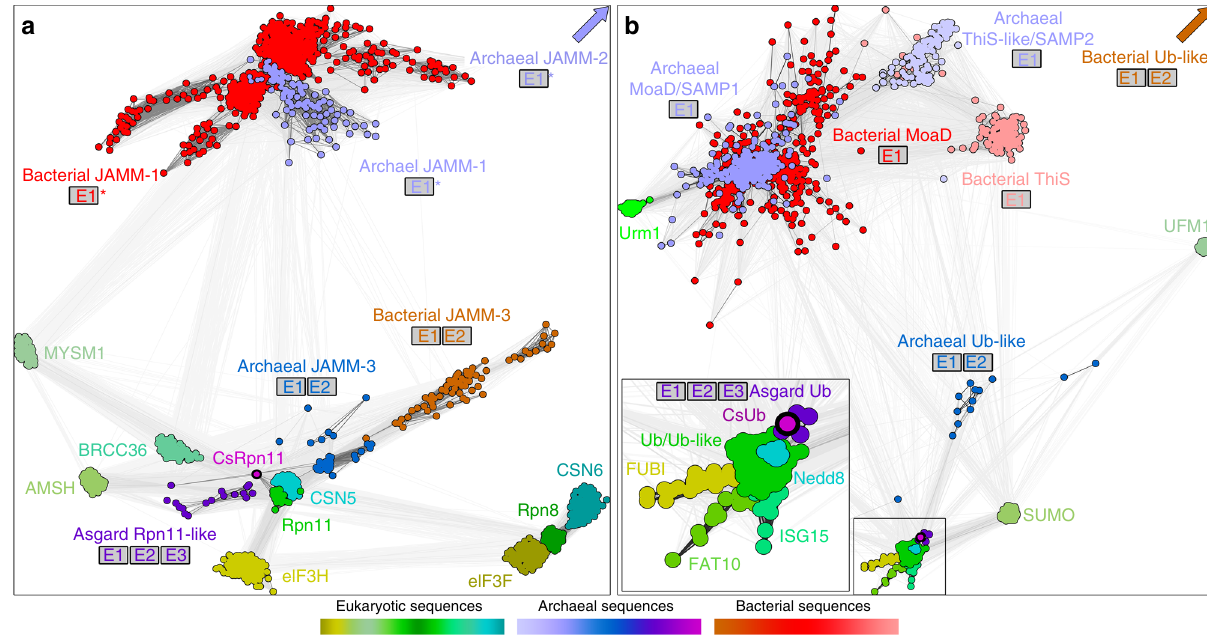
Fig. 1 Sequence relationships of JAMM proteases and ubiquitin-like proteins. a A cluster map of 1543 JAMM core domain sequences. Sequences are represented by dots, the line coloring re fl ects BLAST p values; the darker a line, the lower the p value. For simplicity, the map does not include eukaryotic sequences of the prp8, KIAA0157, and FLJ14981 type as well as bacterial lysM-associated JAMM sequences. For prokaryotic JAMMs, the genomic or functional (asterisks) association with E1/E2/E3 proteins is shown. MYSM1 is a histone H2A deubiquitinase, BRCC36 and AMSH are K63-speci fi c deubiquitinases, and CSN5 cleaves Ub-like Nedd8 59 . CsRpn11 is marked in magenta. b A cluster map of 1473 Ub-like sequences, prepared in the same way as the JAMM cluster map. UFM, Urm1, Sumo, Nedd8, ISG15, FAT10, and FUBI are eukaryotic Ub-like modi fi ers that can be conjugated to target proteins in a similar fashion as Ub 8 . MoaD and ThiS-like proteins function in prokaryotic cofactor synthesis, but can also modify target proteins in some archaea 6 . The inset shows the ubiquitin cluster containing CsUb, marked in